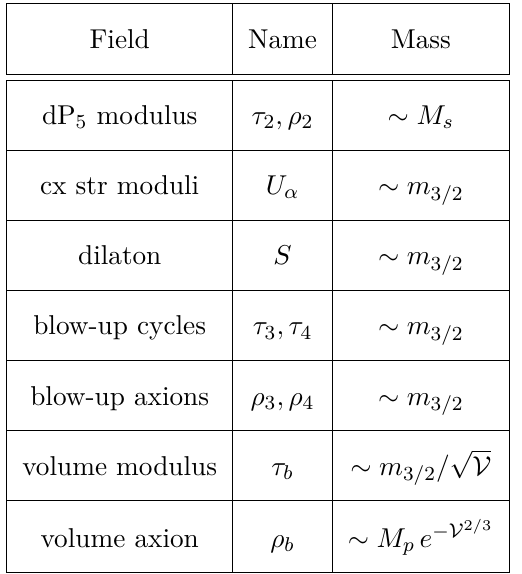
Table 5 . Mass spectrum of the closed string moduli where the axion ρ 2 becomes the longitudinal component of the massive anomalous U(1) at the dP 5